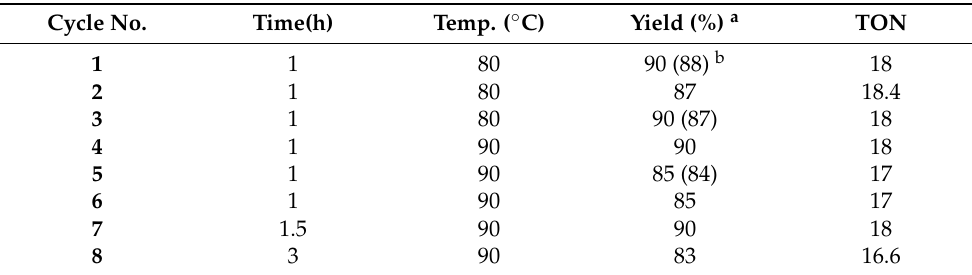
Table 9. Recycling results of B -catalyzed phospha-Michael addition of dimethyl phosphite ( 1b ) with 2-benzylidenemalononitrile ( 3